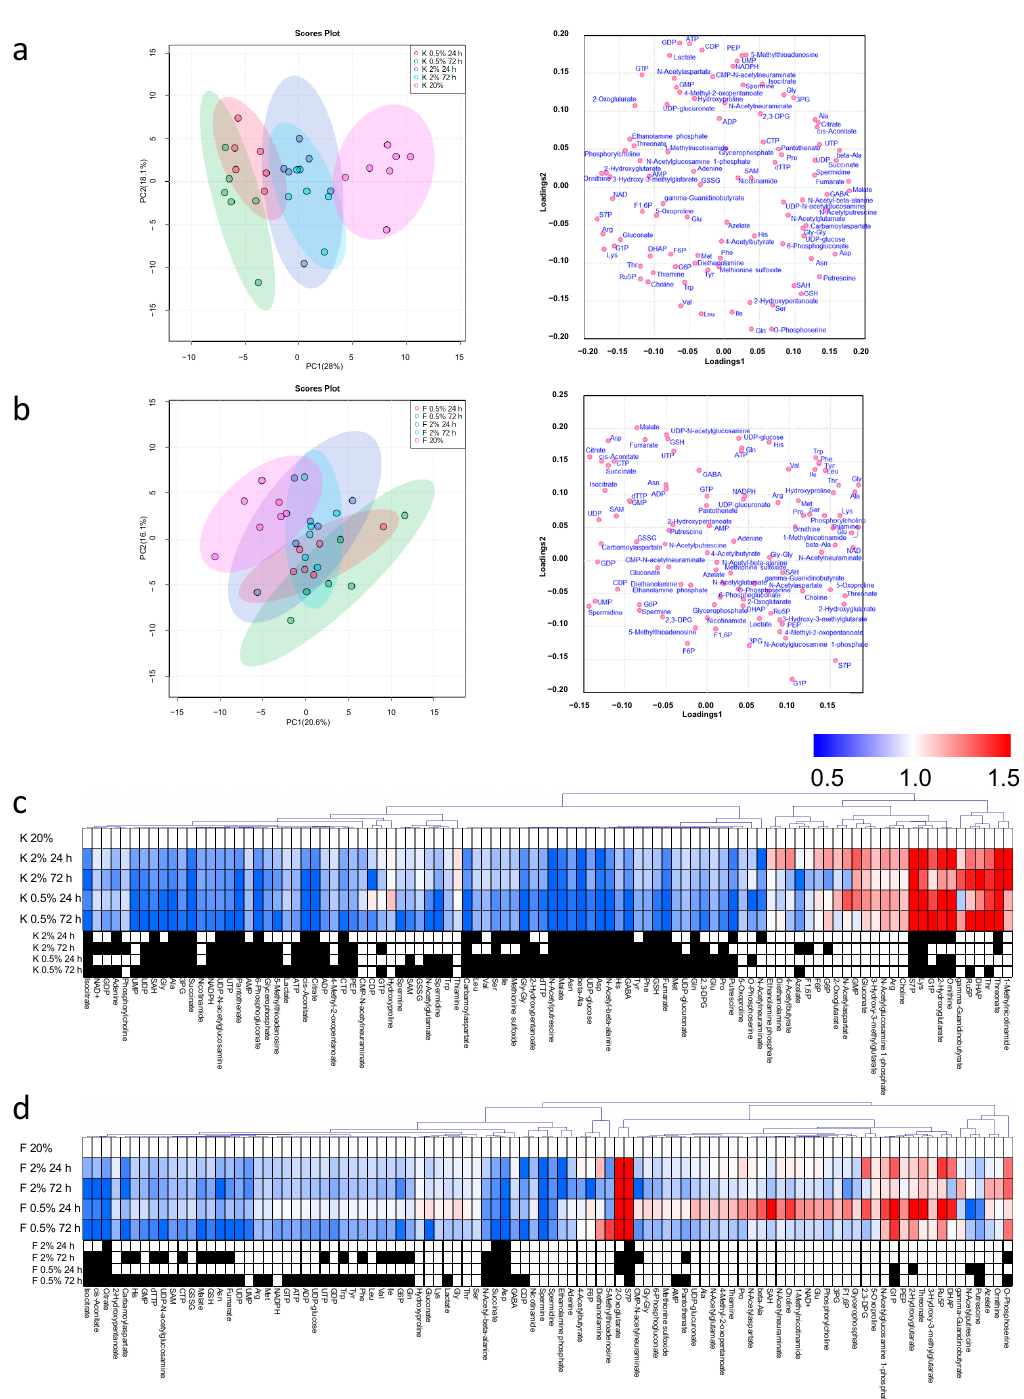
Figure 2. Principal component analyses (PC) of keratinocytes ( a ) and fibroblasts ( b ). The left and right panels were score plots and loading plots, respectively. The X and Y-axes indicated the first and the second PC with contribution ratios. Each plot indicates sample and metabolites in score and loading plots, respectively. Each metabolite concentration was divided by the sum of all metabolite concentrations of each sample, transformed to log 2 and Z-score before PC analysis. Heatmap of keratinocytes ( c ) and fibroblasts ( d ). Each box in the heatmap indicated the fold change (F.C.); i.e., the averaged values of metabolite concentrations of each sample were divided by those of the reference samples cultured under 20% O 2 . The color bar indicated F.C. The black boxes indicated p < 0.05 (Student’s t-test) between each sample and the reference sample. The cells were cultured under the condition with 20% O 2 ( n = 7), 2% O 2 for 24 h ( n = 6), 2% O 2 for 72 h ( n = 6), 0.5% O 2 for 24